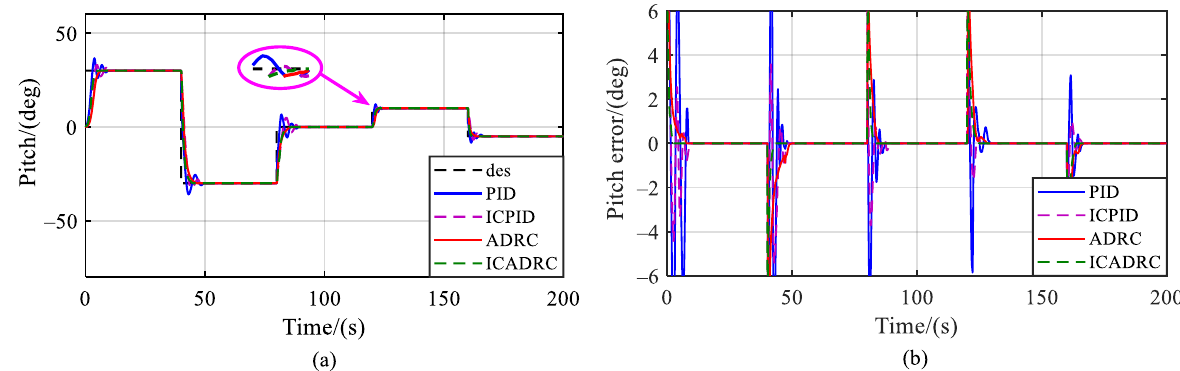
Figure 5. Pitch angle tracking control under square wave signal without external interference. ( a ) The tracking control effects of several controllers under the identical square wave signal; and ( b ) tracking errors of several controllers.